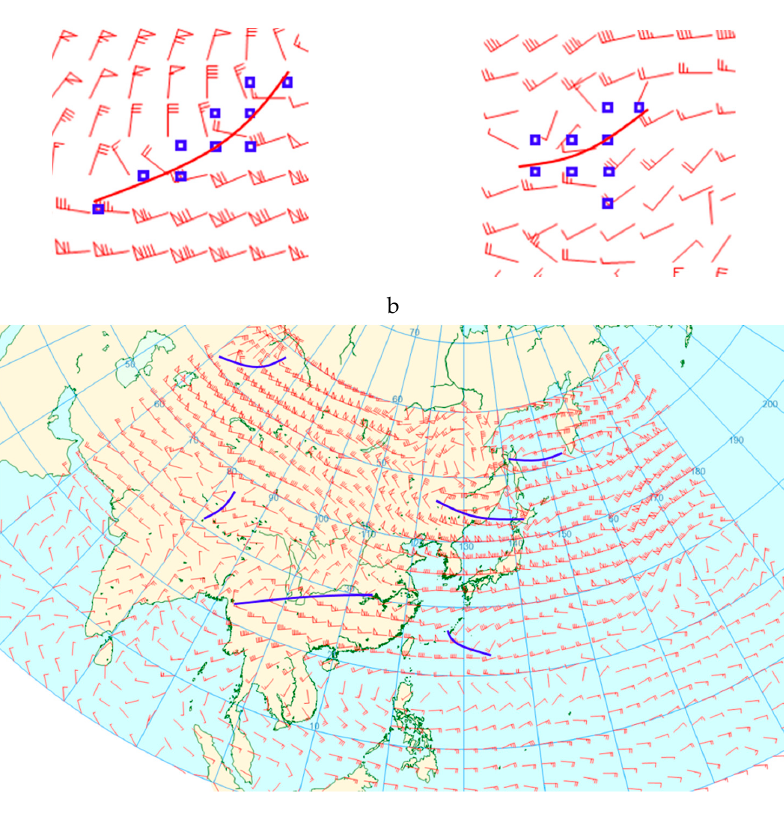
Figure 5. Result from each step of the objective shortwave trough line identification using wind field data from 1600 UTC on 30 April 2009: ( a ) extraction of the candidate shortwave trough points, marked with blue spots. The points in the long-wave trough region are marked with ① and in the area of anticyclonic center are marked with ② ; ( b ) curve fitting of the shortwave trough points; ( c ) identification of the shortwave trough lines (marked with blue solid lines).